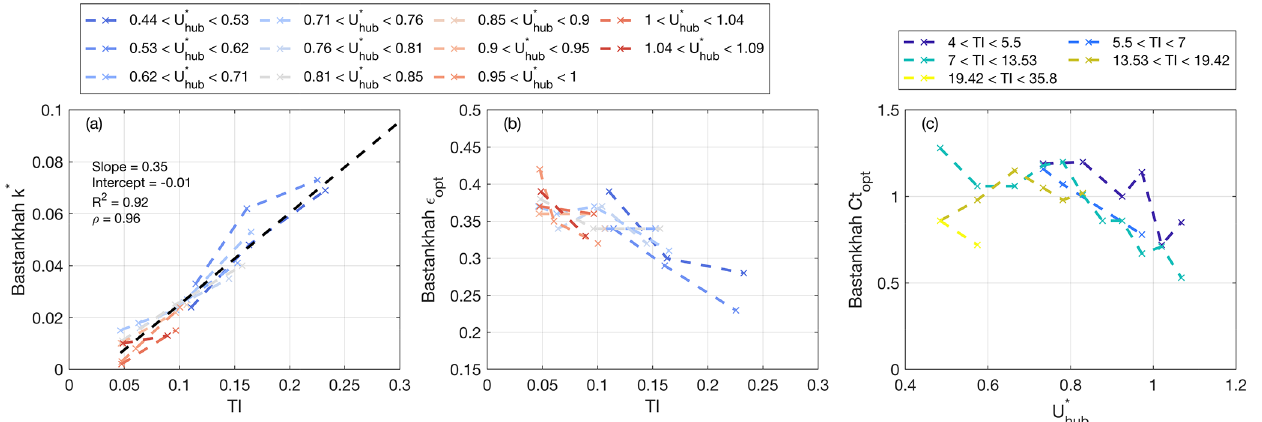
Figure 4. Optimally tuned parameters from Bastankhah wake model: (a) wake expansion parameter, k ∗ , as a function of the incoming wind turbulence intensity, TI (dashed black line is the linear fitting), colored by U ∗ velocity profile, (cid:15) , as a function of the incoming wind turbulence intensity, TI, colored by U ∗